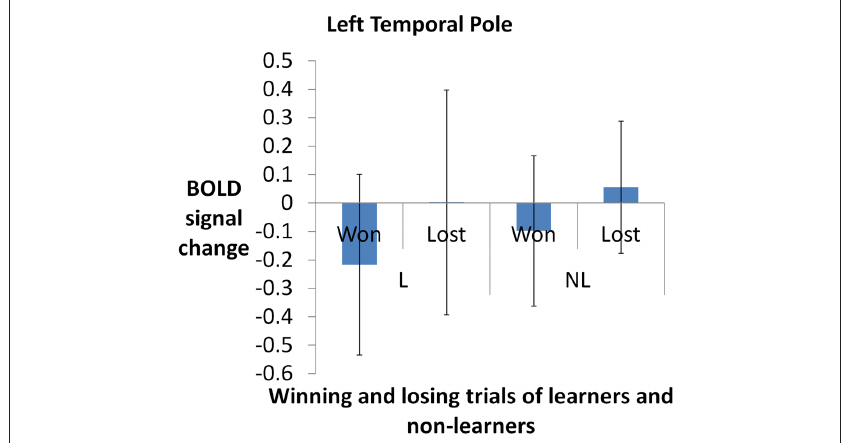
Figure 1 | Blood-oxygenation-level dependent signal change for winning- and losing-trials in the left temporal pole (a region specific to positive emotions i.e., positive minus neutral contrast of iAPS picture rating task. L, learners (who chose from advantageous card decks more frequently). NL, non-learners. Activity was higher for the winning trials, F (3,57) = 7.562, p < 0.001. Error bars denote SD of